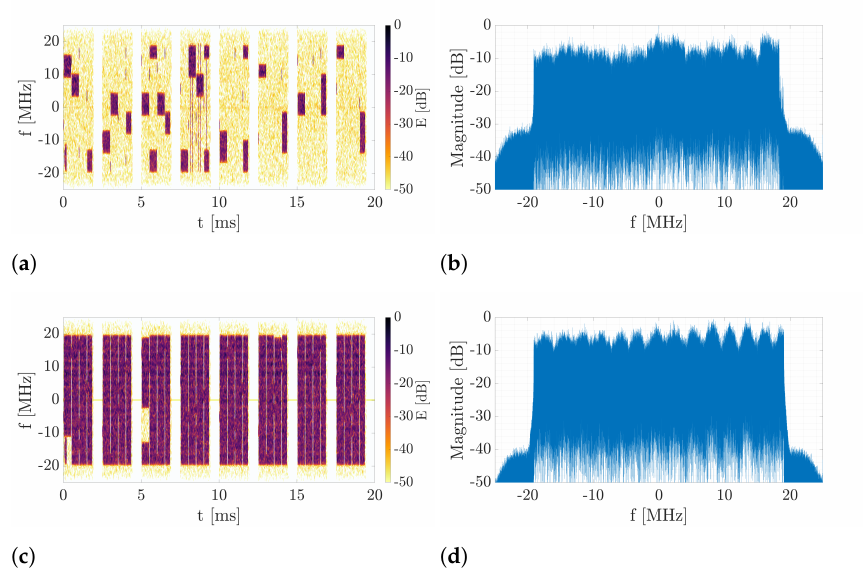
Figure 9. Example of spectrograms and spectrum plots for different amount of content in real-life 5G signal. ( a ) Spectrogram for some content. ( b ) spectrum for some content. ( c ) Spectrogram for no content. ( d ) spectrum for no